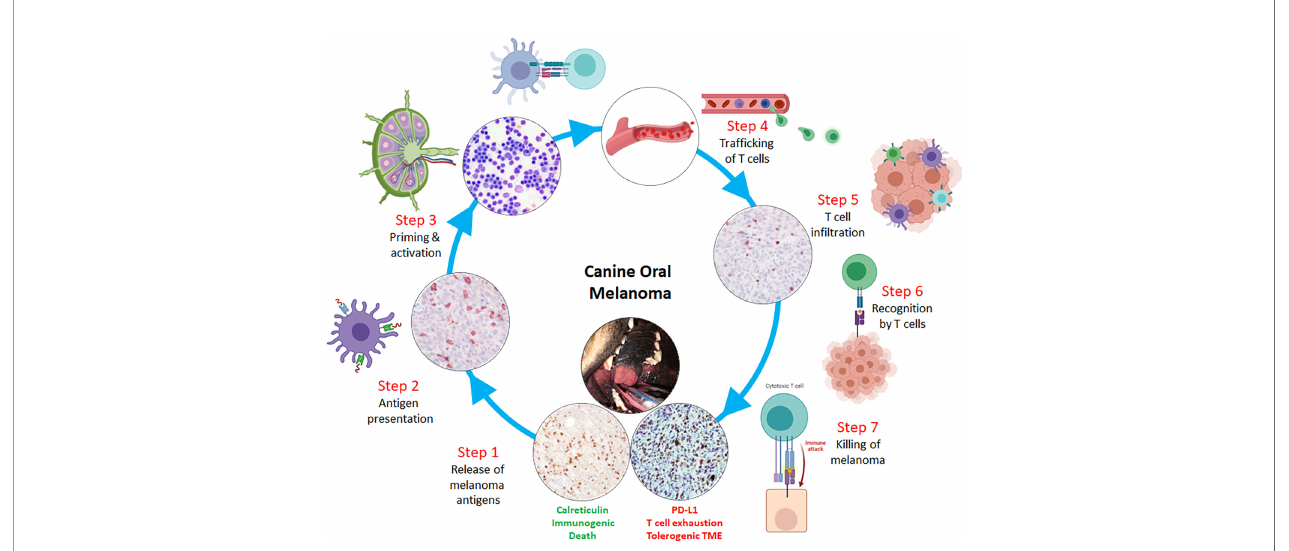
FIGURE 3 | Rational design of immunotherapeutic strategies through a comparative oncology approach including canine oral malignant melanoma as a model tumor for correcting potential breaks in the cancer-immunity cycle. Sequential or combinatorial interventions can be evaluated at each potential break within the cycle, starting with: Step 1 - release of melanoma antigens following immunogenic cell death; Step 2 - suf fi cient intratumoral dendritic cell/macrophage processing and presentation of melanoma antigens with subsequent migration to secondary lymphoid organs; Step 3 - effective priming and activation of naïve T lymphocytes; Step 4 - intravasation and extravasation of activated T lymphocytes through hematogenous and/or lymphatic routes; Step 5 - suf fi cient T lymphocyte in fi ltration through microenvironment and into melanoma parenchyma; Step 6 - T cell receptor engagement with melanoma MHC class I:peptides; and Step 7 - effector T lymphocyte killing of melanoma